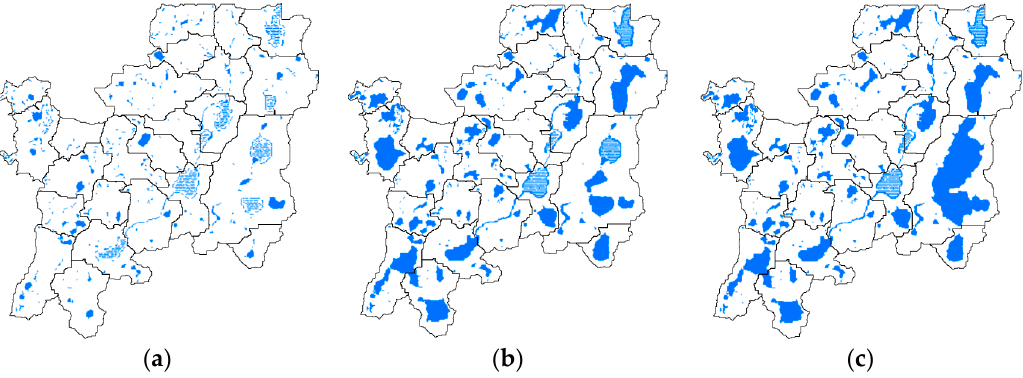
Figure 4. Spatial distributions and hierarchical relationships of puddles (blue color) delineated by the Puddle Delineation (PD) program for three selected puddle levels ( a ) level 1 (initial puddle level); ( b ) level 50; and ( c ) level 243 (final puddle level).